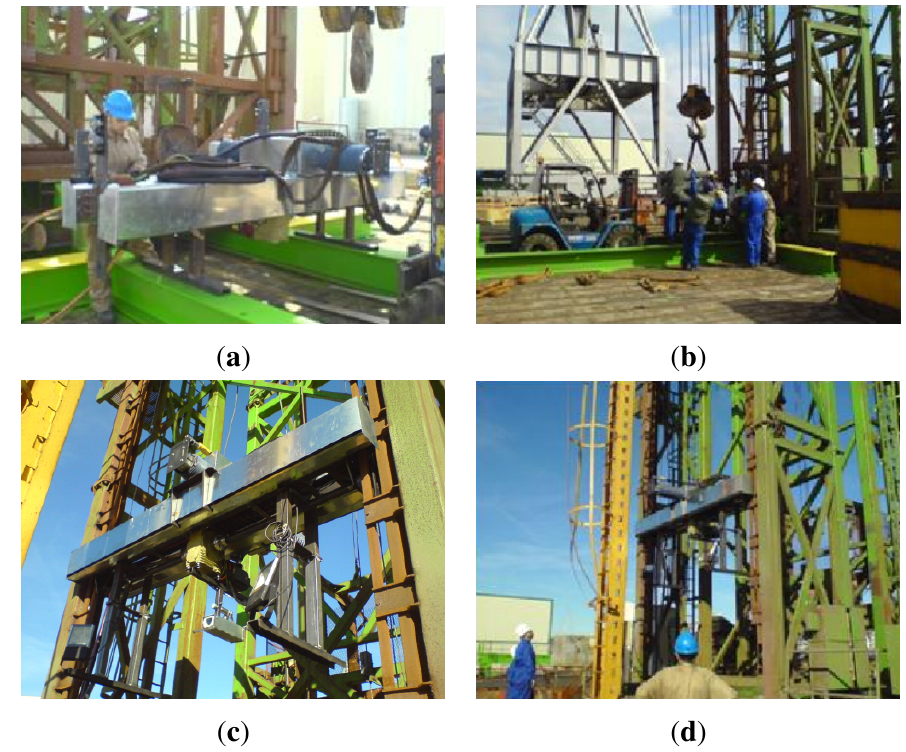
Figure 16. Assembly of the prototype on the shipyard’s cranes. ( a ) New secondary structure; ( b ) and ( c ) Coupling operations carried out on the primary structure; ( d ) Final appearance of the primary and secondary structures after the coupling